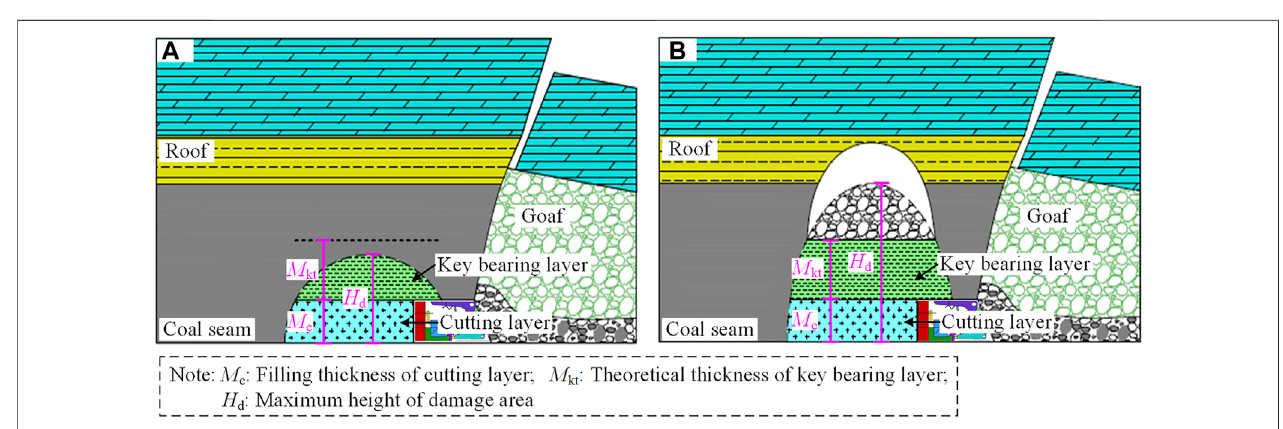
FIGURE 5 | Two patterns of damage zone fi lling: (A) M kt + M c ≤ H d ; (B) M kt + M c > H d .